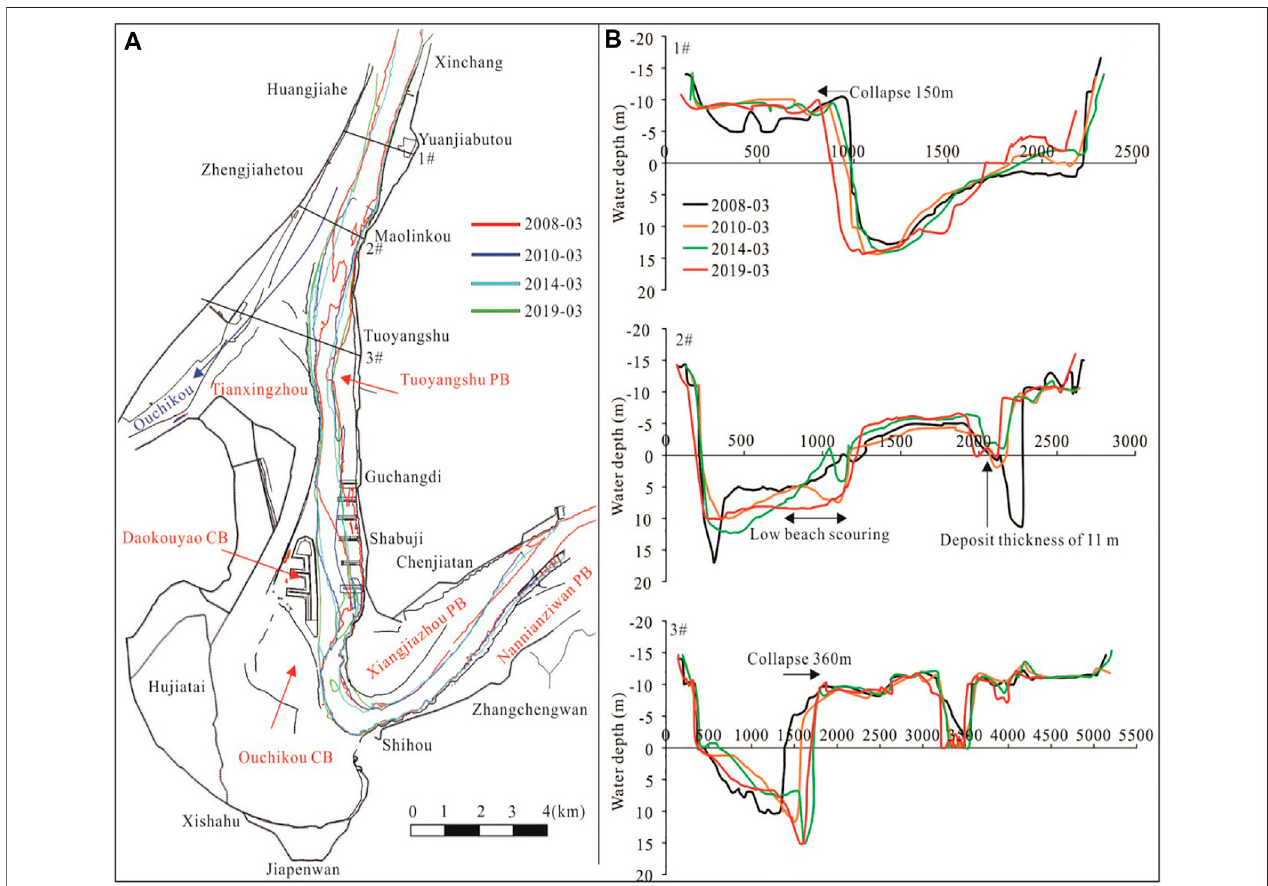
FIGURE 13 | Changes of waterway and channel conditions in the con fl uence area of the Tianxingzhou – Ouchikou reach; (A) Length of 4.5 m isobath in the Tianxingzhou – Ouchikou reach; (B) Transverse section changes.